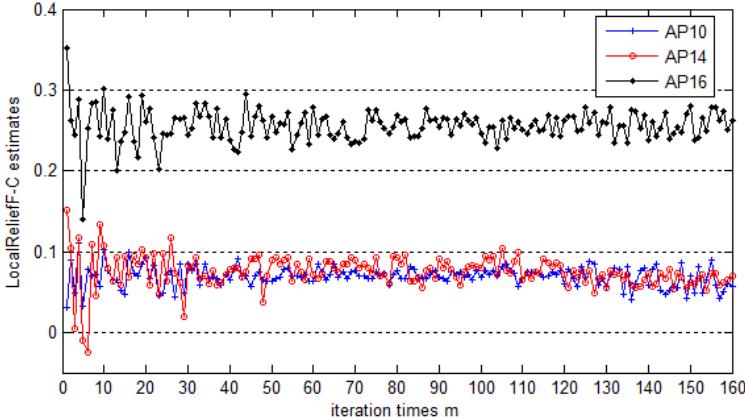
Figure 7. Estimated weights change with iteration m at reference Location 1.